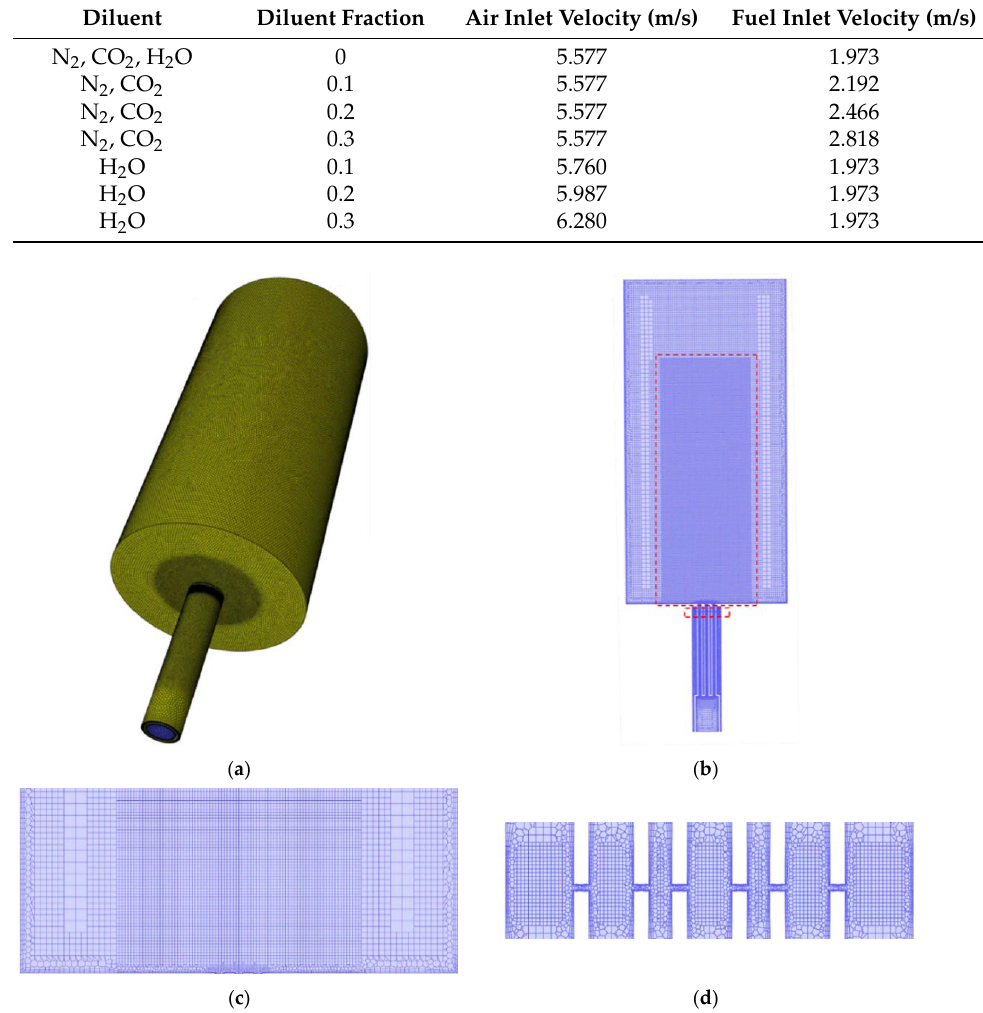
Figure 3. Comparison of the experimental and simulated NO emission. Table 2. The fuel and CO 2 volumetric content. Number